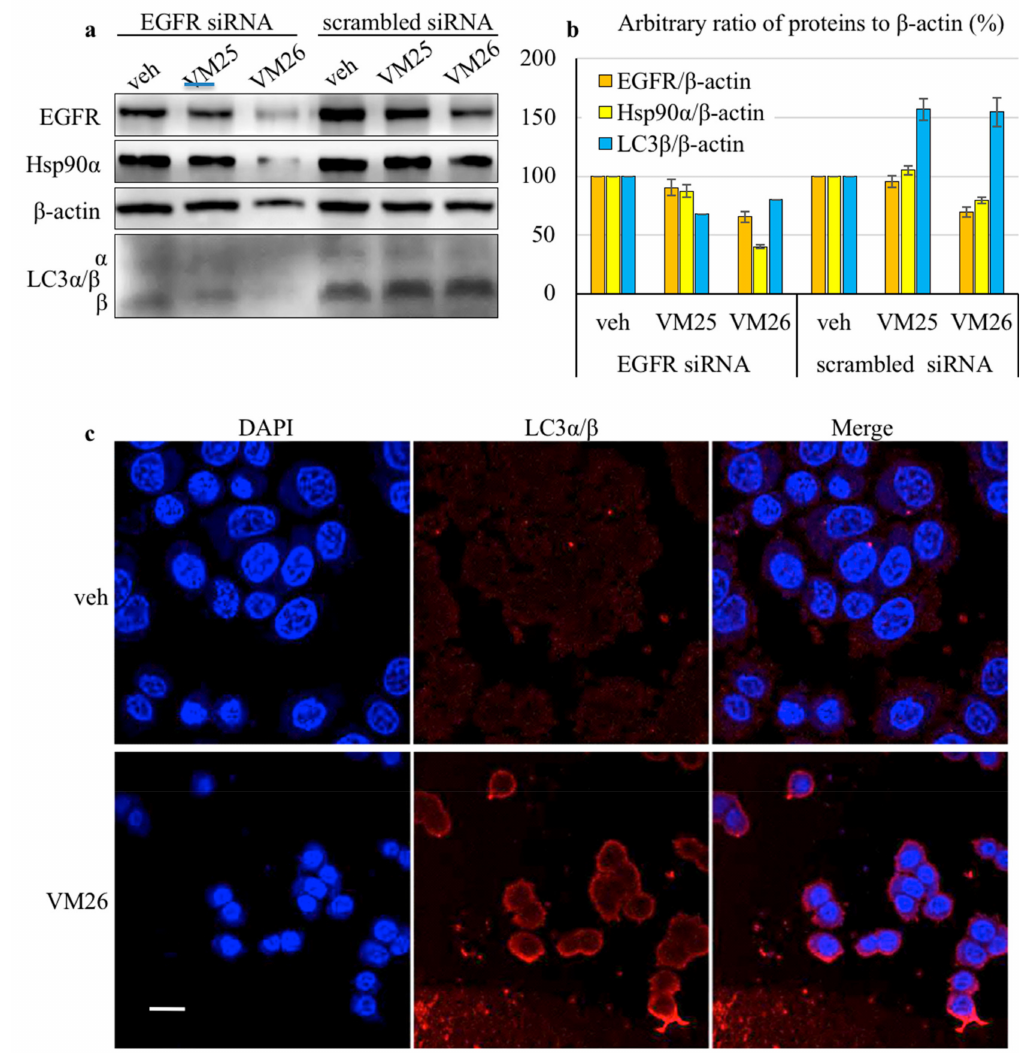
Figure 3. Small compounds activate microautophagy in cancer cells. ( a ) Western blot of proteins extracted from MDA-MB-468 cells after transfection with EGFR siRNAs or scrambled siRNAs and exposure to 25 µ M VM25 and VM26 for 2 h in serum-deprived Dulbecco’s Modified Eagle Medium (DMEM). ( b ) Relative levels of proteins were estimated as the ratio to β -actin and adjusted to the vehicle-treated cells normalized to 100%. ( c ) Immunofluorescence detection of LC3 α / β in MDA-MB-468 cells exposed to 2.5 µ M VM26 for 1 h. The size bar is equal to 10 µ